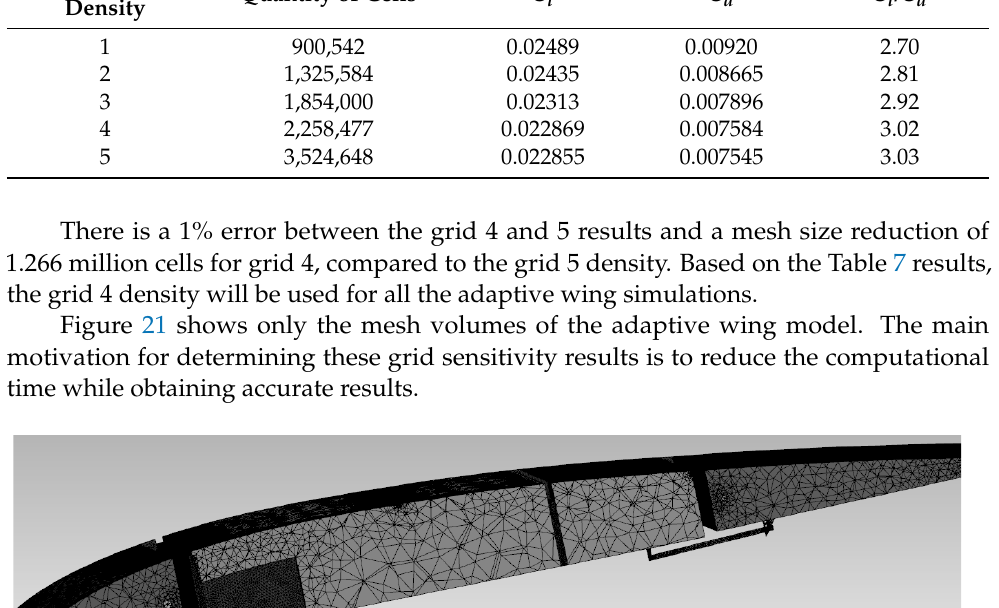
Table 7. Grid sensitivity results.